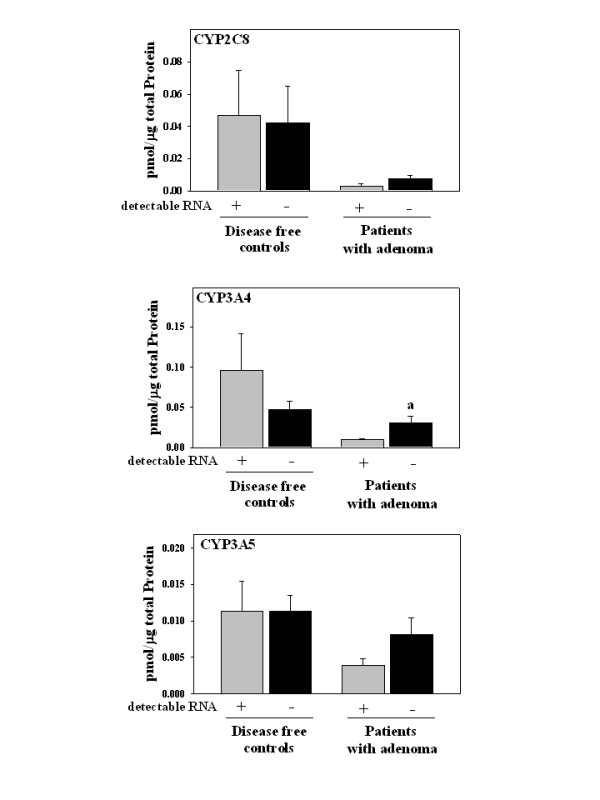
Relation of CYP2C8, CYP3A4, CYP3A5 protein levels and mRNA expression pattern in normal colon mucosa of cases and disease-free controls. Comparison of protein levels of CYP2C8, CYP3A4, and CYP3A5 of patients and disease-free controls, respectively, with detectable mRNA expression and those with no detectable mRNA expression of the respective CYP. Data are mean ± SEM. ap < 0.05 compared to disease-free controls.